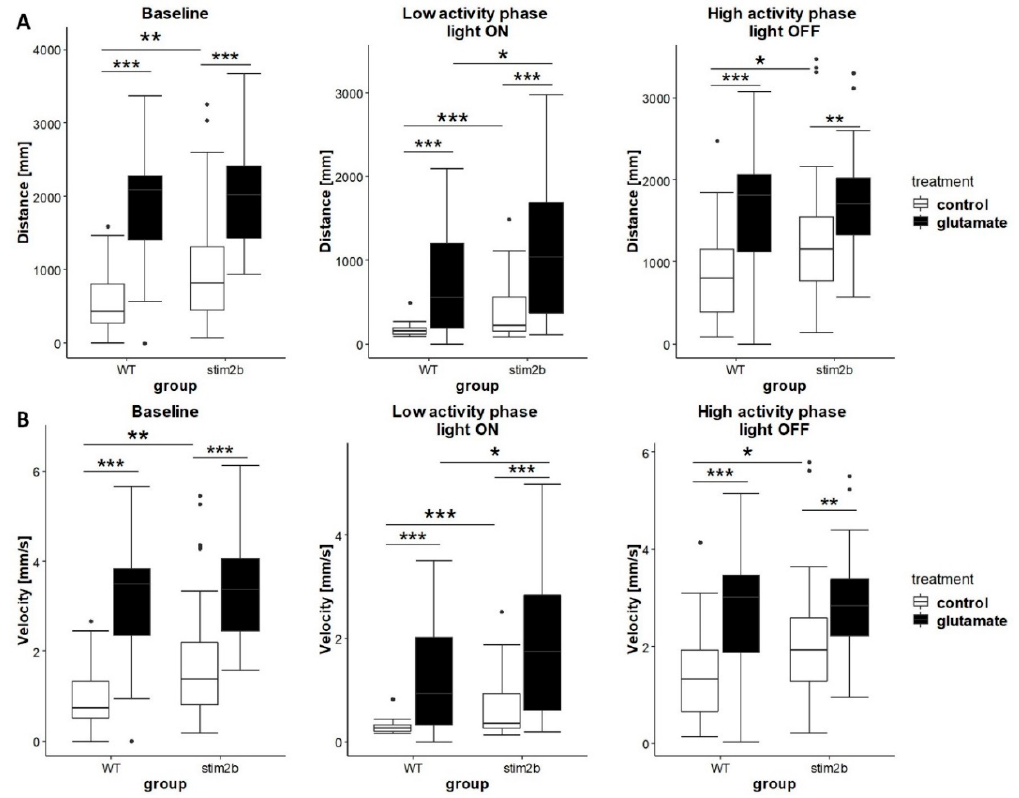
Figure 7. Glutamate treatment induced a stronger response in stim2b − / − mutants than in WT